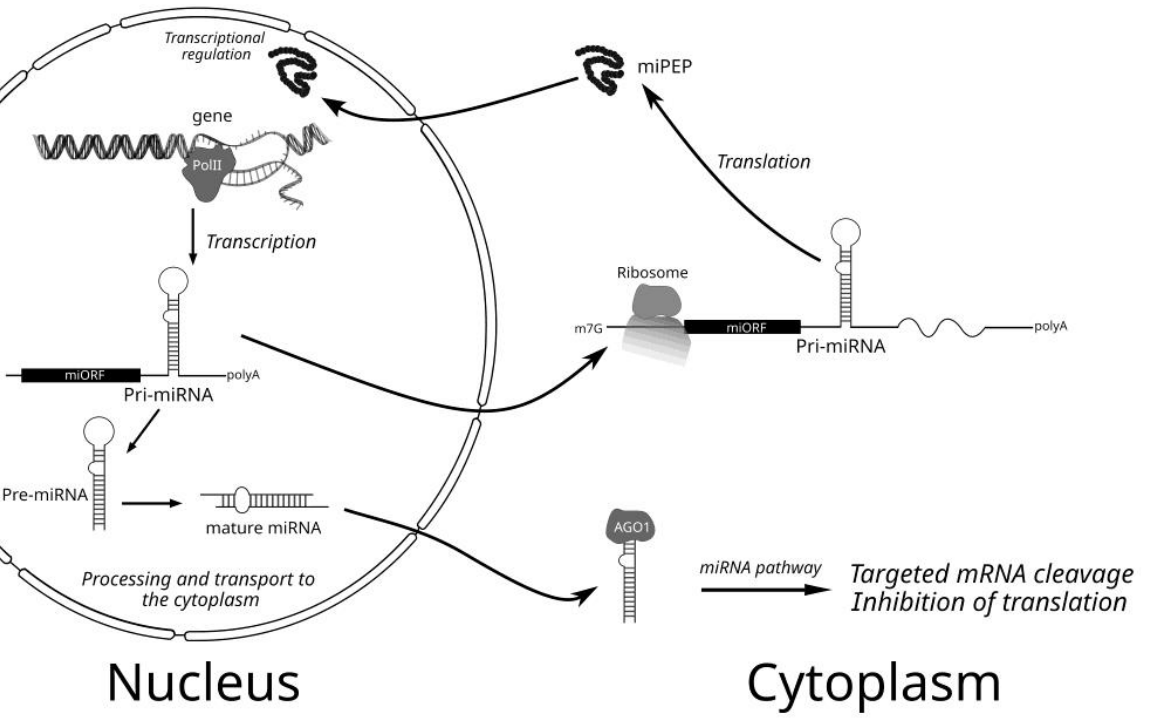
Figure 1. Schematic presentation of the plant cell processes of pri-miRNA/miRNA synthesis, pro- cessing, and action as well as producing and action of